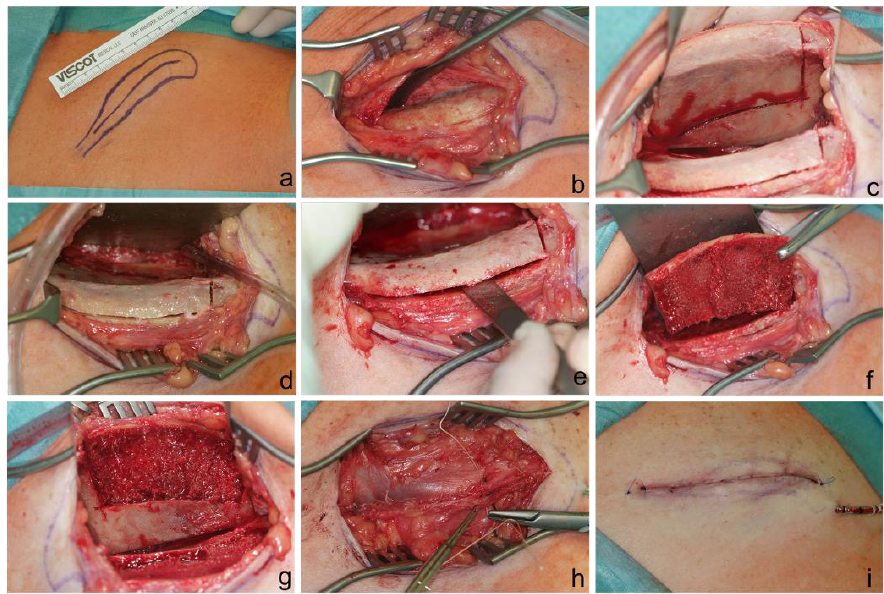
Figure 1. Procedure of grafting a cortical bone block from the right anterior iliac crest. ( a ) Marking of the anterior iliac crest. ( b ) Preparation of the anterior iliac crest. ( c , d ) Circumscribing the bone graft with a saw (( c ): mirror instrument used). ( e ) Careful carving of the bone block. ( f , g ) Removal of the cortical block (( g ): mirror instrument mirror used). ( h ) Iterative wound closure. ( i ) Closed wound with inserted drain.